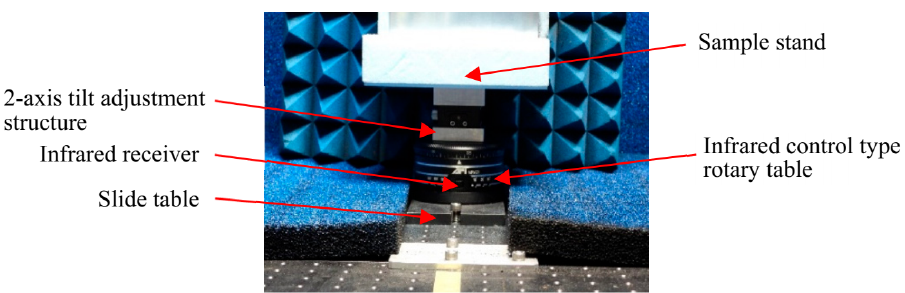
Figure 10. Sample stand installed on an infrared control type rotary table.